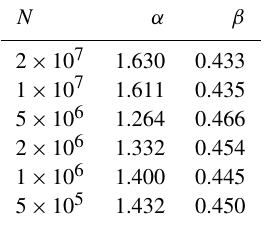
Table 2. Parameter values of the power-law relation between eroded area and fluvial threshold (Eq. 14) obtained from different simulated drainage networks on triangular lattices with N nodes for θ = 0 . 5. N α β 2 × 10 7 1.630 0.433 1 × 10 7